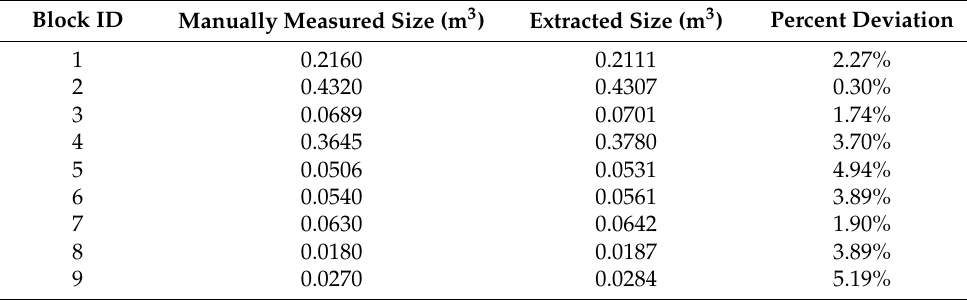
Table 2. Comparison results between extracted block sizes and manually measured sizes.